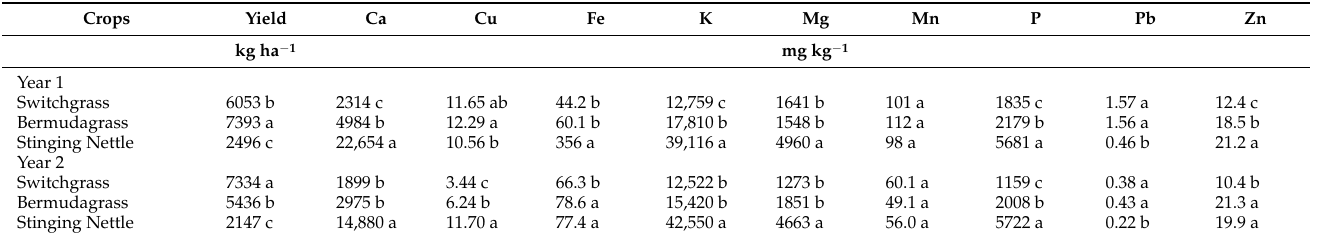
Table 5. Nutrient and metal concentrations averaged over forage crops for the first and second